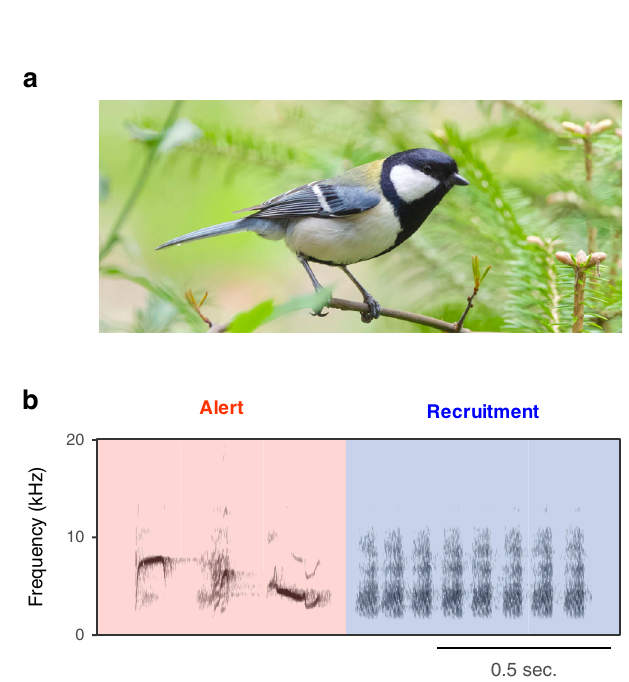
Fig. 2 | Study system. Japanese tits ( a ) combine alert and recruitment calls into alert-recruitment call sequences ( b ) when gathering other individuals to mobbing of a